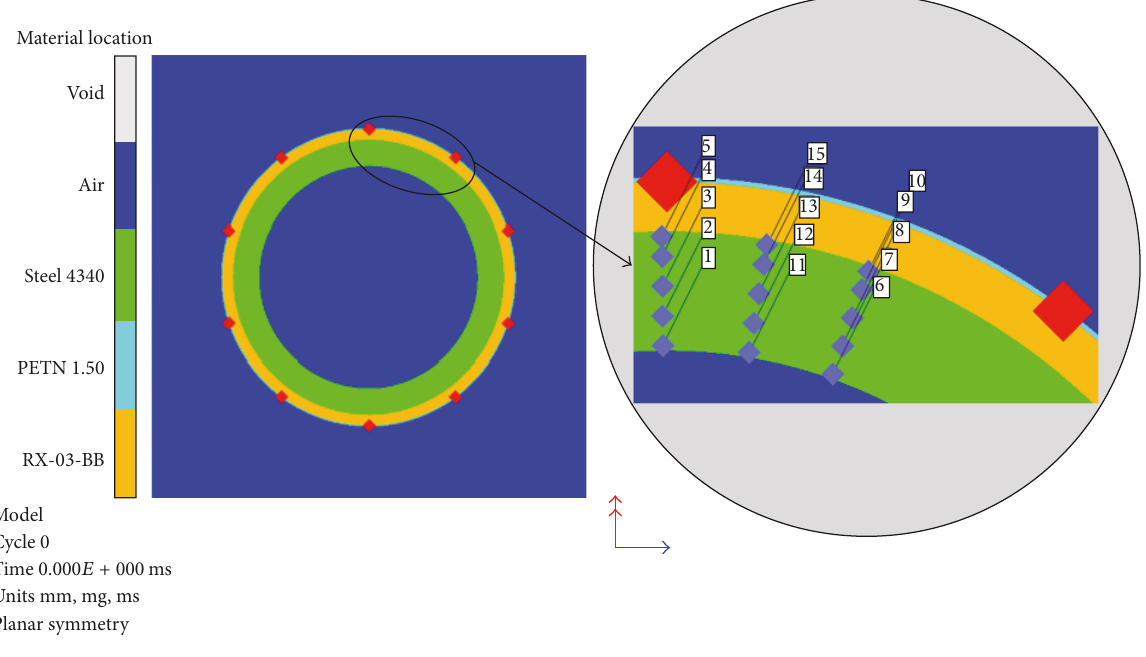
Figure 9: Numerical model.